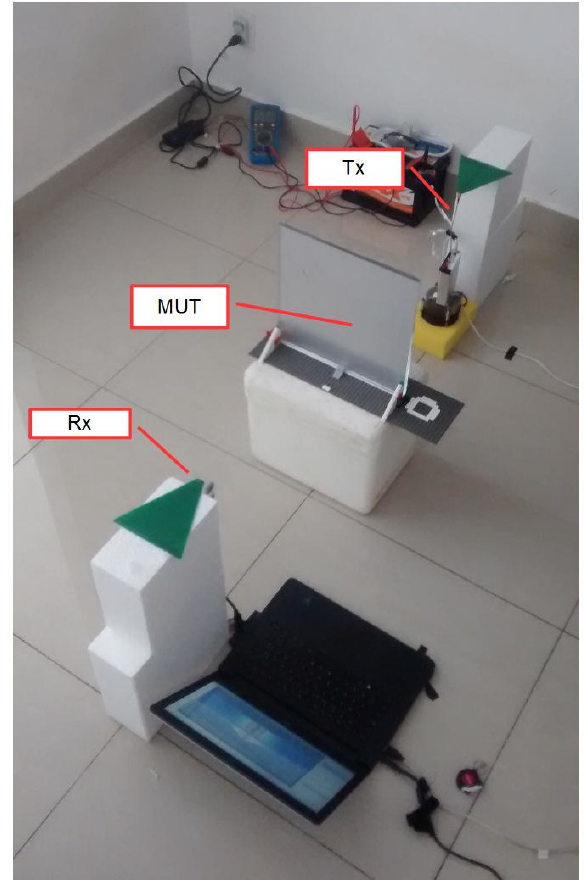
Figure 2. The free-space setup. The antennae and material are held by low permittivity blocks (extruded polystyrene foam) and small plastic pieces. From top to bottom, we have the battery for powering the transmitter (Tx), the Tx itself, the slab of the material in the center of the setup, the receiver (Rx), and the computer that controls the radios and measurements. In the photo, there is metal foil on the surface of the MUT; thus, this is the MET